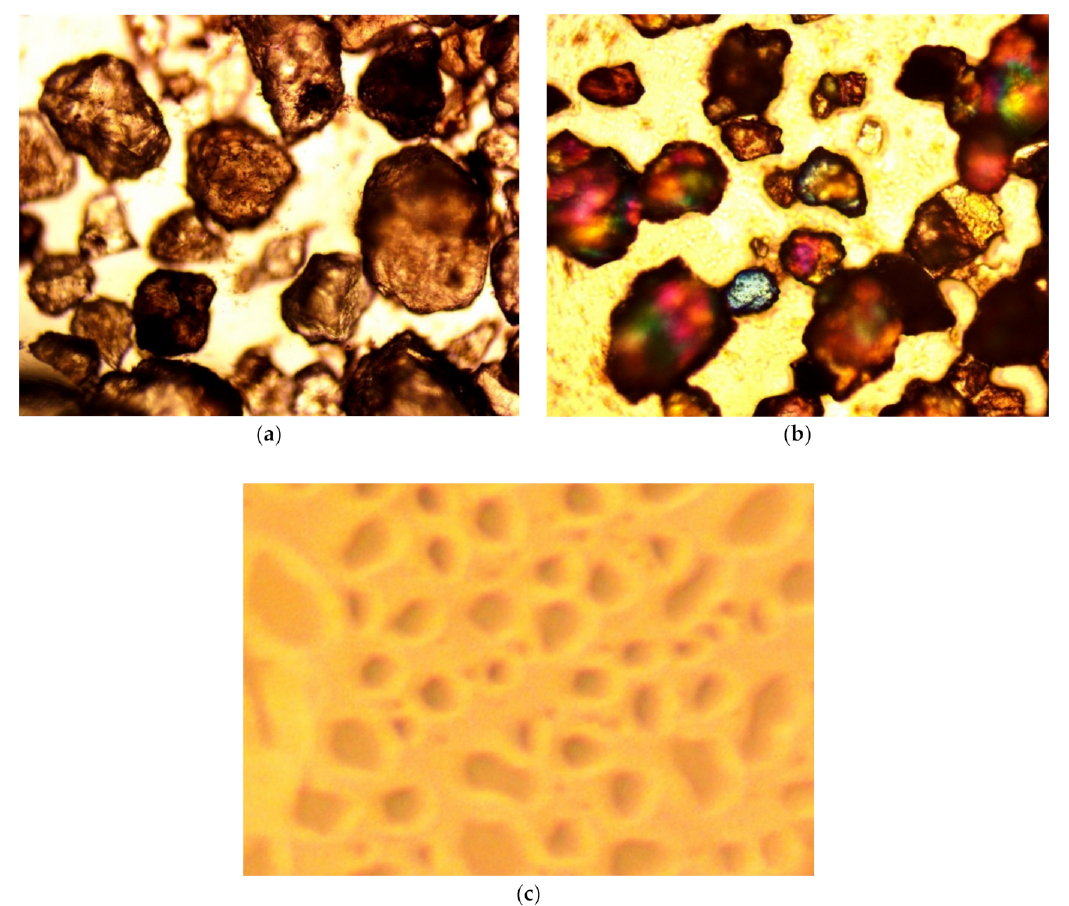
Figure 18. Extracted catalyst following the processing of 50 batches of water. ( a ) Catalyst: transmitted light, field of view = 1.3 mm; ( b ) catalyst: circular polarized light, field of view = 1.3 mm; ( c ) pore water precipitate: transmitted light, field of view = 0.03